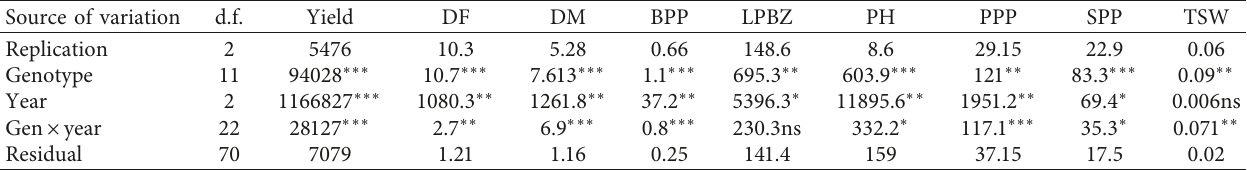
Table 3: Combined mean squares for different agronomic traits of sesame